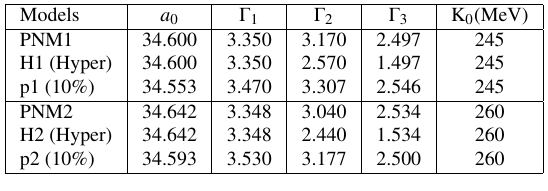
Table 2: Parameters of polytropes used as equations of state for the Tolman-Oppenheimer-Volko ff calculations.